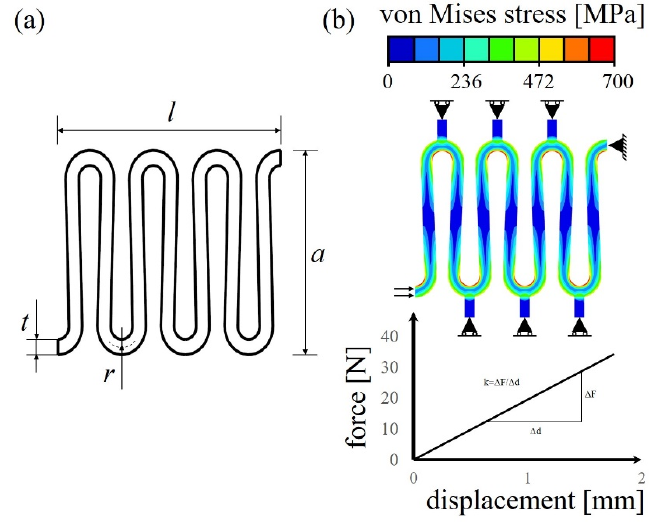
Figure A2. Model and simulations for dimensioning the spring mechanism. ( a ) Contour of a spring design for additive manufacturing, ( b ) von Mises stresses for a spring width of 3 mm at a displace- ment of 1.75 mm with implemented boundary conditions and force–displacement curve of the com- pressed spring.